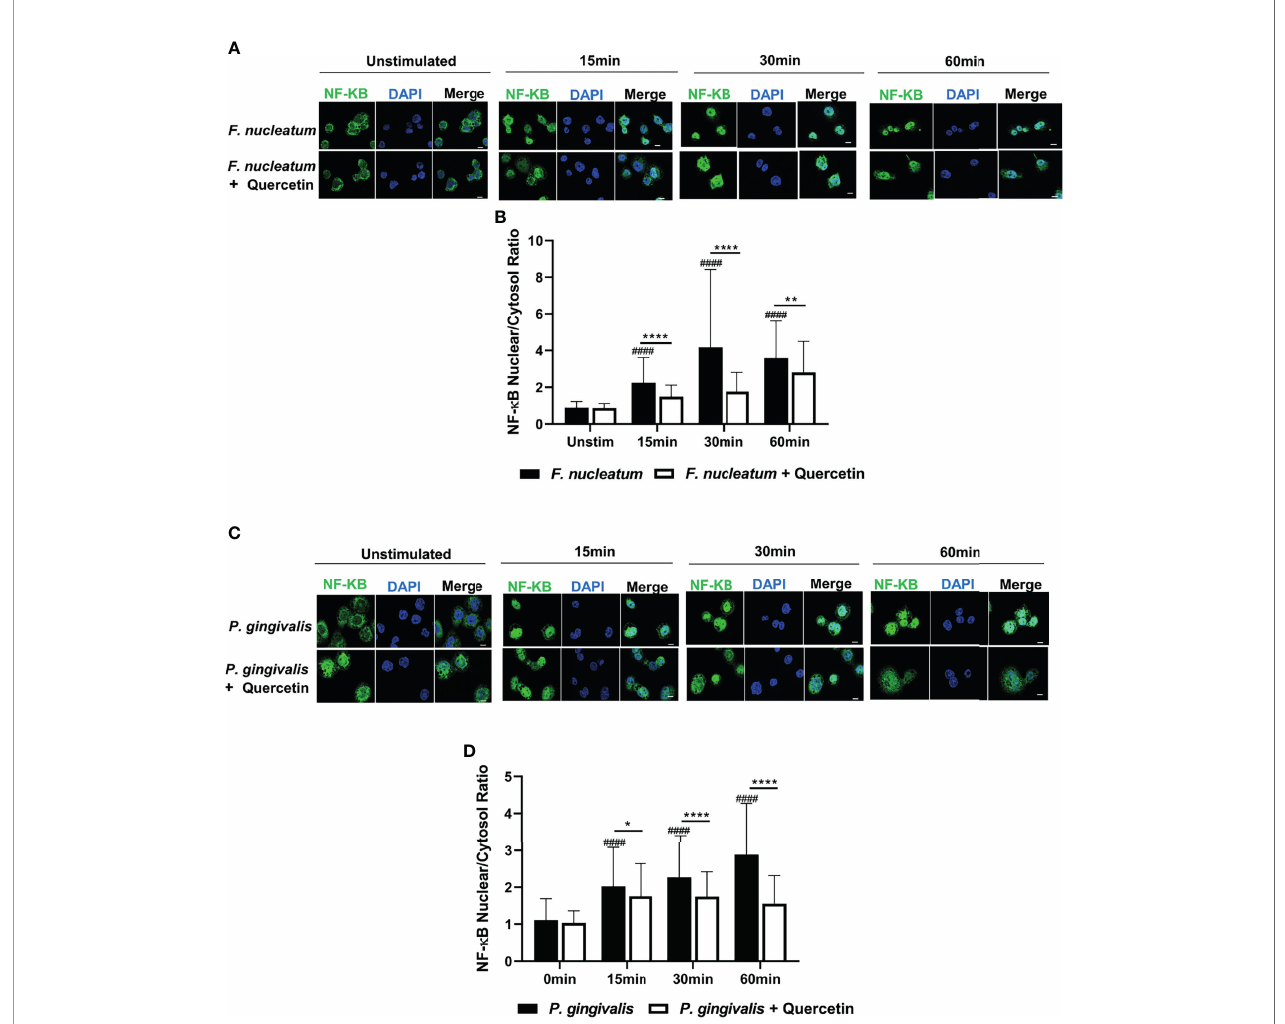
FIGURE 5 | Quercetin decreases NF- k B nuclear translocation upon LPS-and oral bacteria-induced in fl ammation in human macrophages. THP-1 macrophages treated with Quercetin (5µg/mL) or vehicle matched control were infected with LPS or oral bacteria for indicated times. NF- k B was stained with NF- k B antibody followed by Alexa-Fluor488 (green) and the nucleus was stained with DAPI (blue). Images were captured with Nikon Confocal laser microscope. (A) Representative images of vehicle- and Quercetin-treated cells infected with F. nucleatum (25 MOI) (C) and P. gingivalis (50MOI) and the quantitative analysis of nuclear to cytosolic ratio of NF- k B was shown, respectively (B, D) . Scale bars=10µM. Data are representative of three independent experiments and averages and standard deviations are shown. *p ≤ 0.05, **p ≤ 0.01, ****p ≤ 0.0001. #### Unstimulated control cells versus corresponding stimulated cells (p ≤